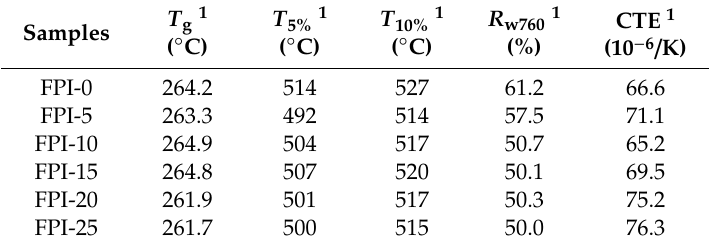
Figure 8. Di ff erential scanning calorimetry (DSC) curves FPI films at a heating rate of 10 ◦ C / min under nitrogen flow. Table 1. Thermal properties of the FPI / TSP composite